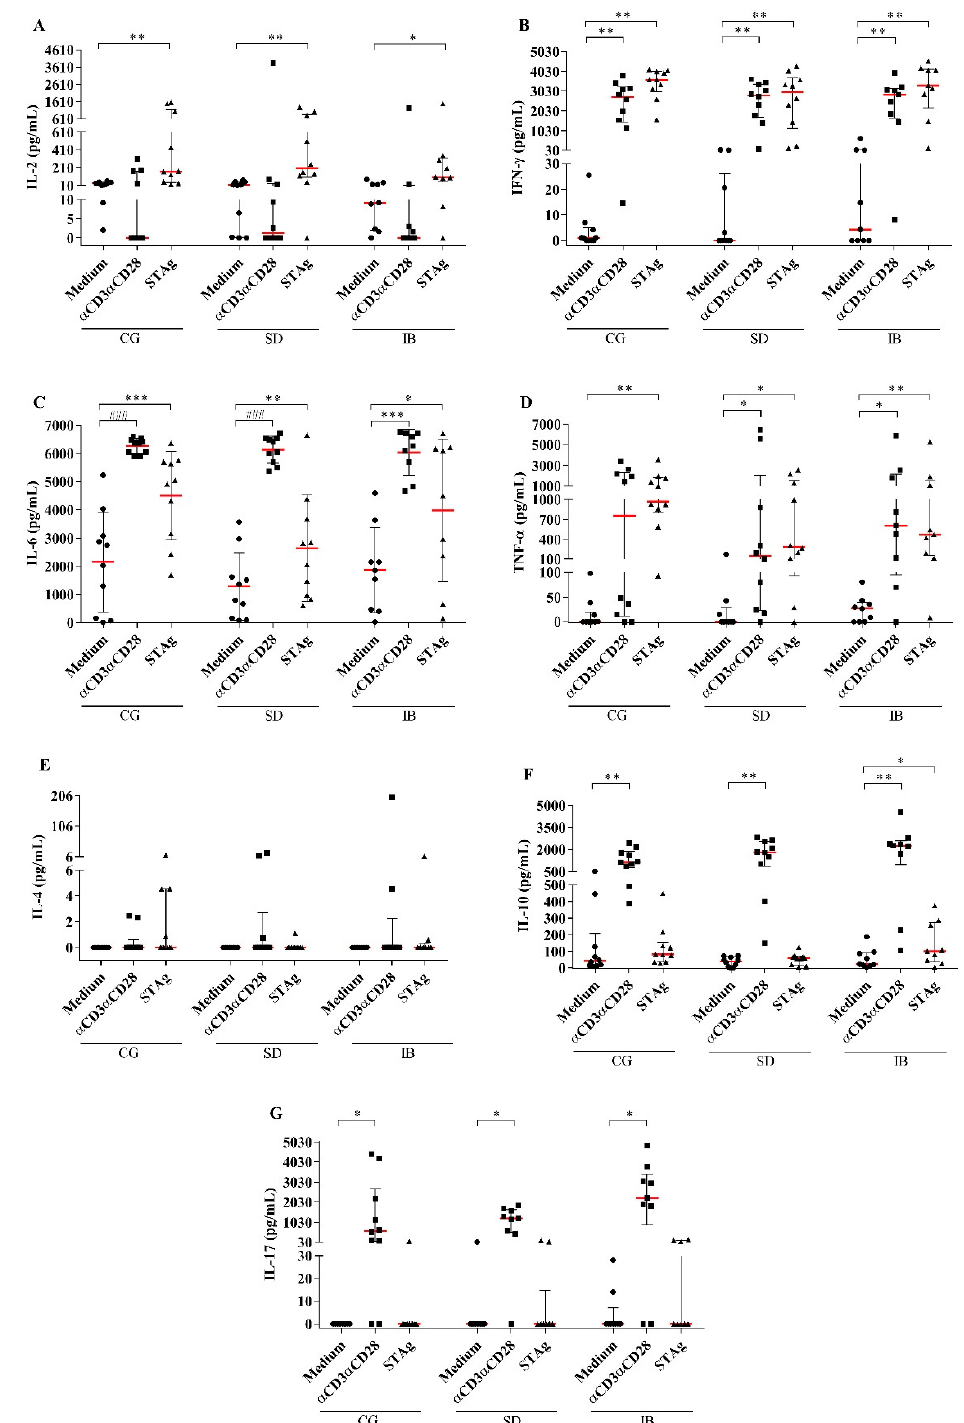
Figure 7. Cytokine production in cell culture supernatant. Cytokine levels of ( A ) IL-2, ( B ) IFN- γ , ( C ) IL-6, ( D ) TNF- α , ( E ) IL-4, ( F ) IL-10, and ( G ) IL-17, expressed in pg/mL, quantified after 96 h of stimulation with anti-CD3 and anti-CD28, STAg, and absence of stimulus in groups CG, SD, and IB, by CBA. Analysis between stimuli by Wilcoxon (except in C, paired T -test) and among the groups by Kruskal–Wallis (except in C, ordinary one-way ANOVA). The horizontal bars represent the medians with interquartile ranges or means with standard deviation. Statistically significant data, * p < 0.05, ** p < 0.005, *** p < 0.0005, and ### p < 0.0001.